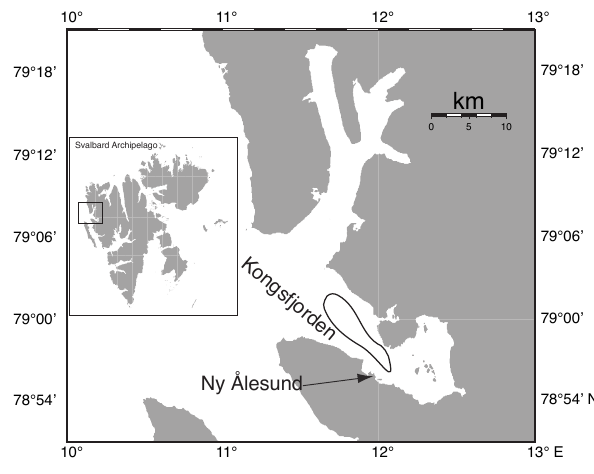
Fig. 1. Map of Kongsford highlighting the sampling